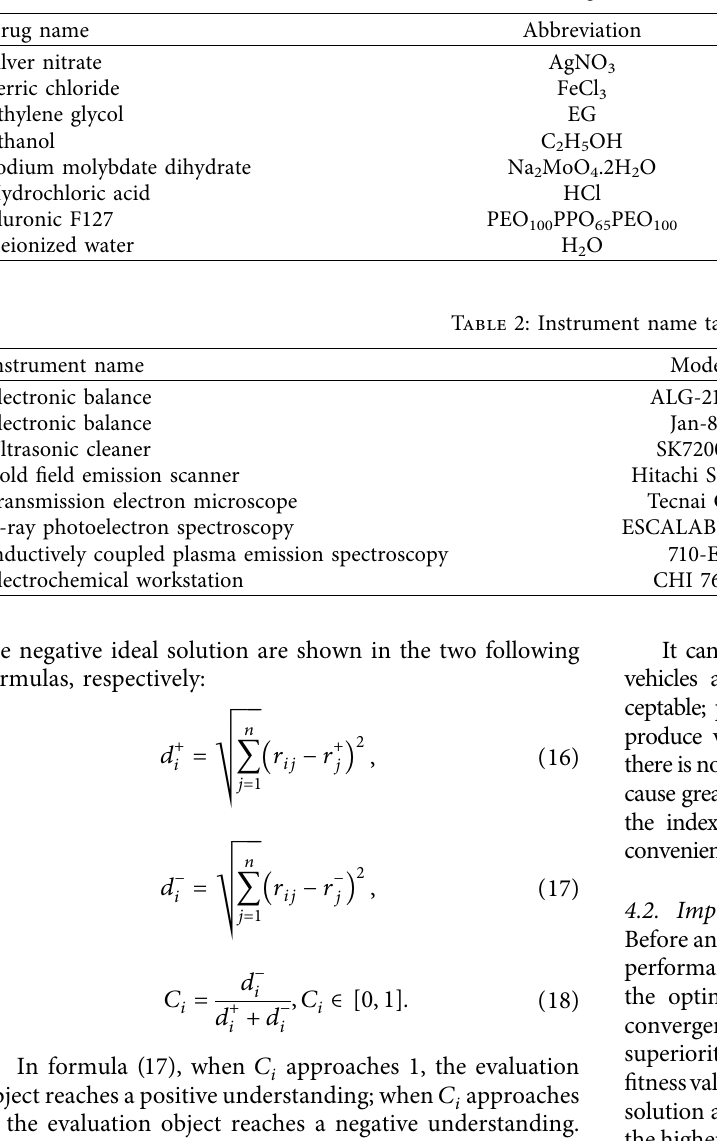
Table 1: Reagent name table.